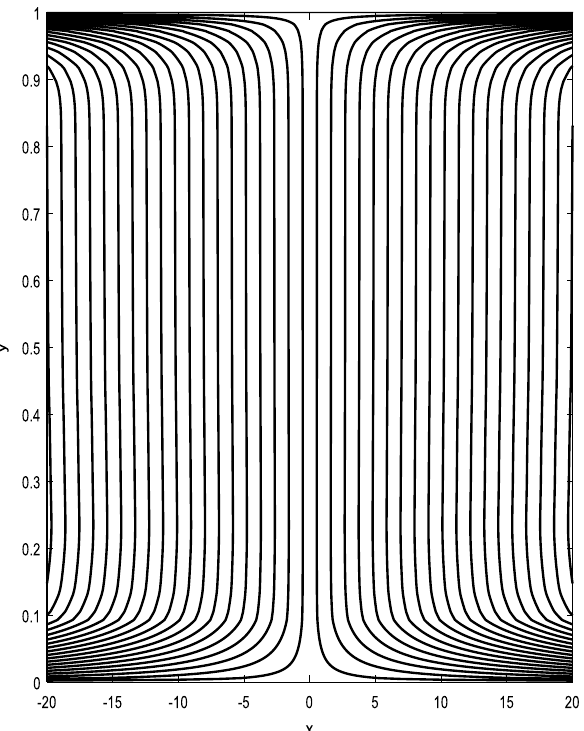
Figure 38. Stream lines profile at F = 0.6 and Da = 1.